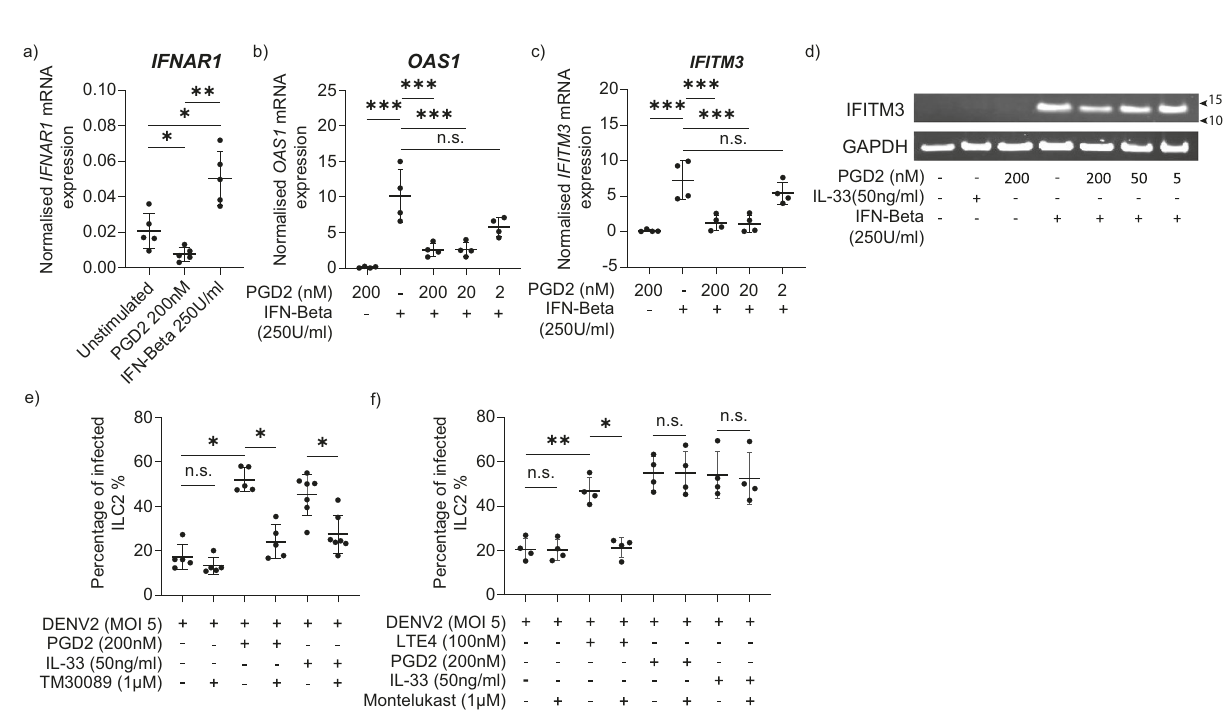
Fig. 4 ILC2 activation through PGD2 increased the infectivity of ILC2. a Real-time PCR analysis of IFNAR1 gene expression by ILC2 following 2 h of stimulation with PGD 2 (200 nM) and IFN- β (250 IU/ml). ( n = 5, one-way ANOVA with Tukey ’ s multiple comparison test, data representative of